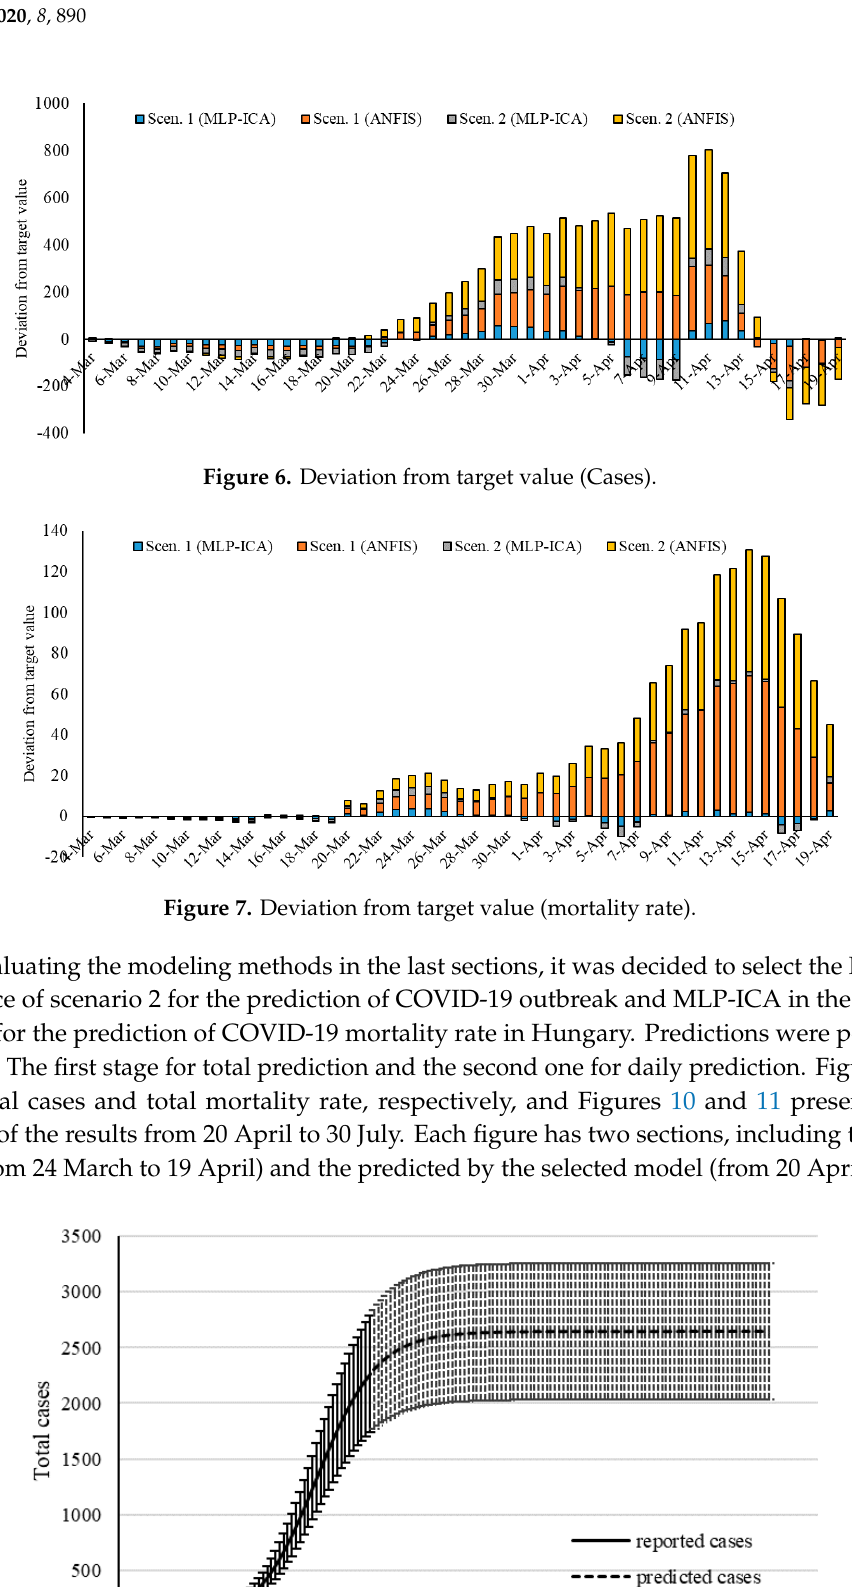
Figure 8. Total outbreak prediction for MLP-ICA.